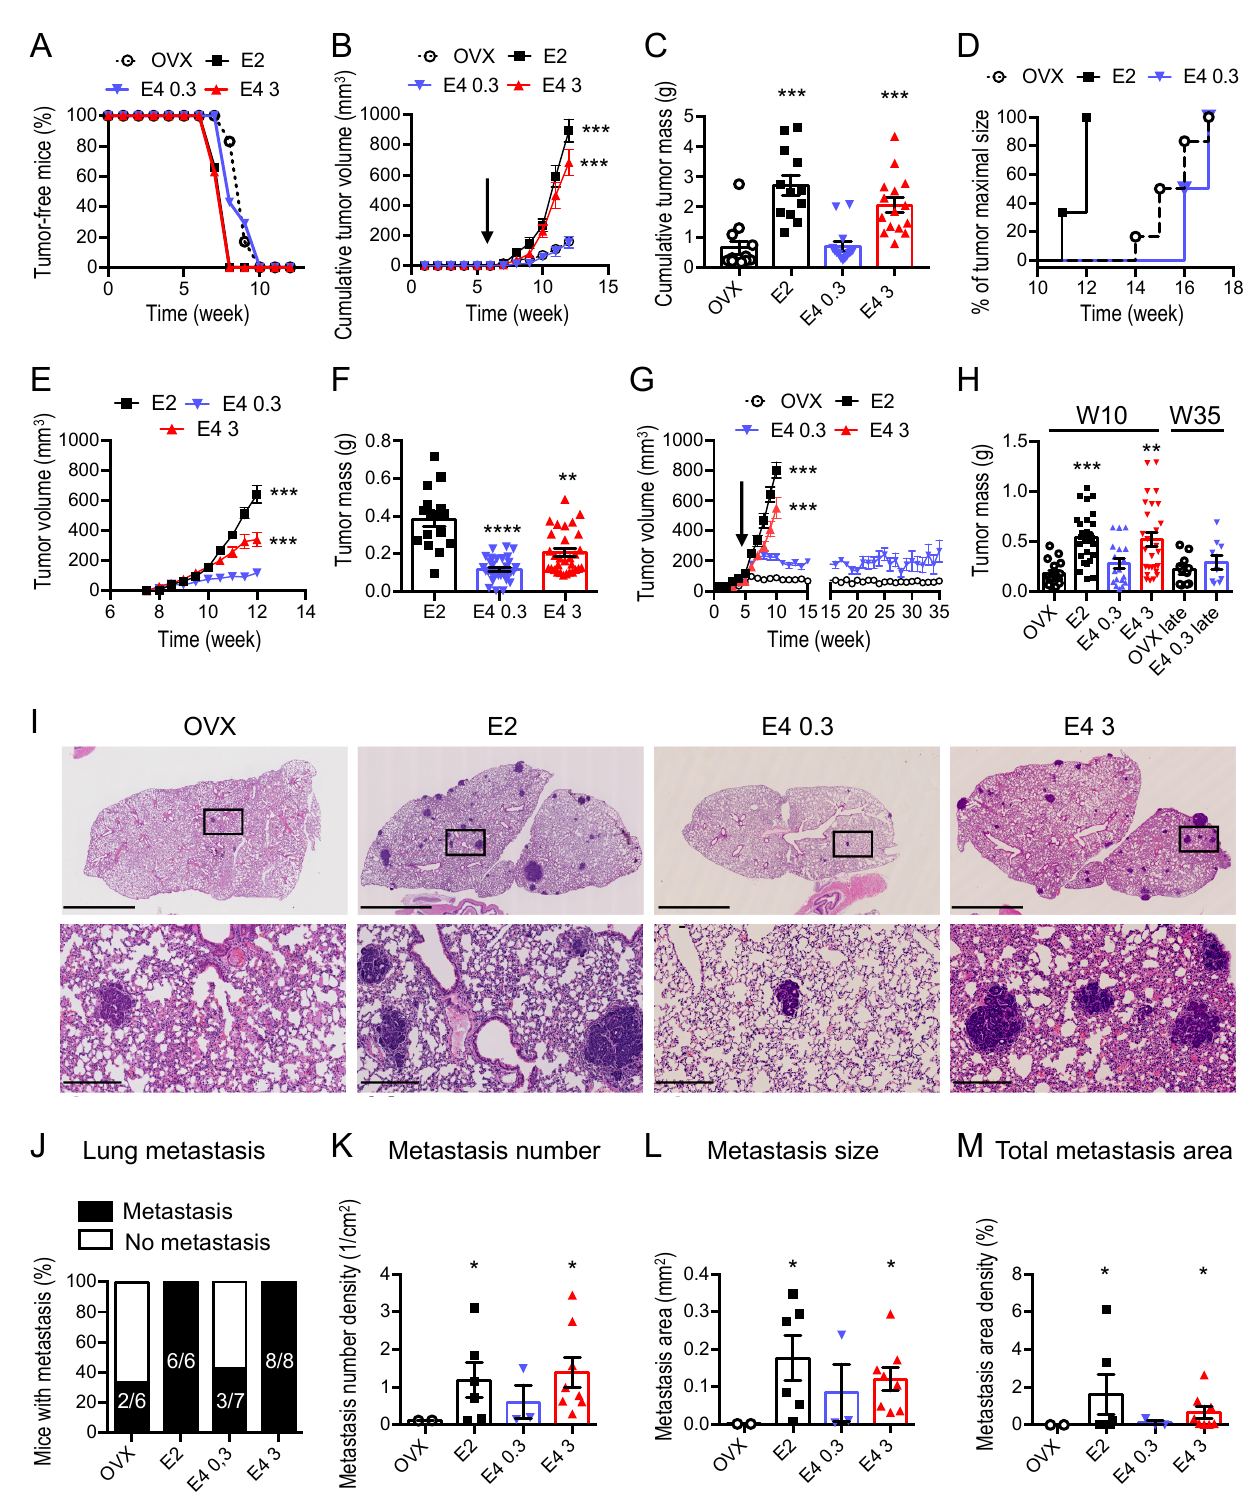
Figure 2. Dose-dependent effect of E4 on breast cancer progression . ( A ) Tumor appearance assessed by the percentage of tumor-free mice in ovariectomized MMTV-PyMT treated with E2 (0.08 mg/kg/day) or E4 (0.3 or 3 mg/kg/day). ( B ) Tumor growth kinetics (treatment start pointed by the arrow), ( C ) tumor mass and ( D ) tumor growth delay. ( E ) Tumor growth kinetics and ( F ) tumor mass of MCF7 xenografts from mice untreated (OVX) or treated with E2 (0.08 mg/kg/day) or E4 (0.3 or 3 mg/kg/day). ( G ) Tumor growth kinetics (treatments started five weeks after engraftment as pointed by the arrow) and ( H ) tumor mass of PDX from mice untreated (OVX) or treated with E2 (0.08 mg/kg/day) or E4 (0.3 or 3 mg/kg/day) for 5 (W10) or 30 weeks (W35). ( I ) Hematoxylin/eosin staining of lungs harvested from MMTV-PyMT mice; scale bar = 2.5